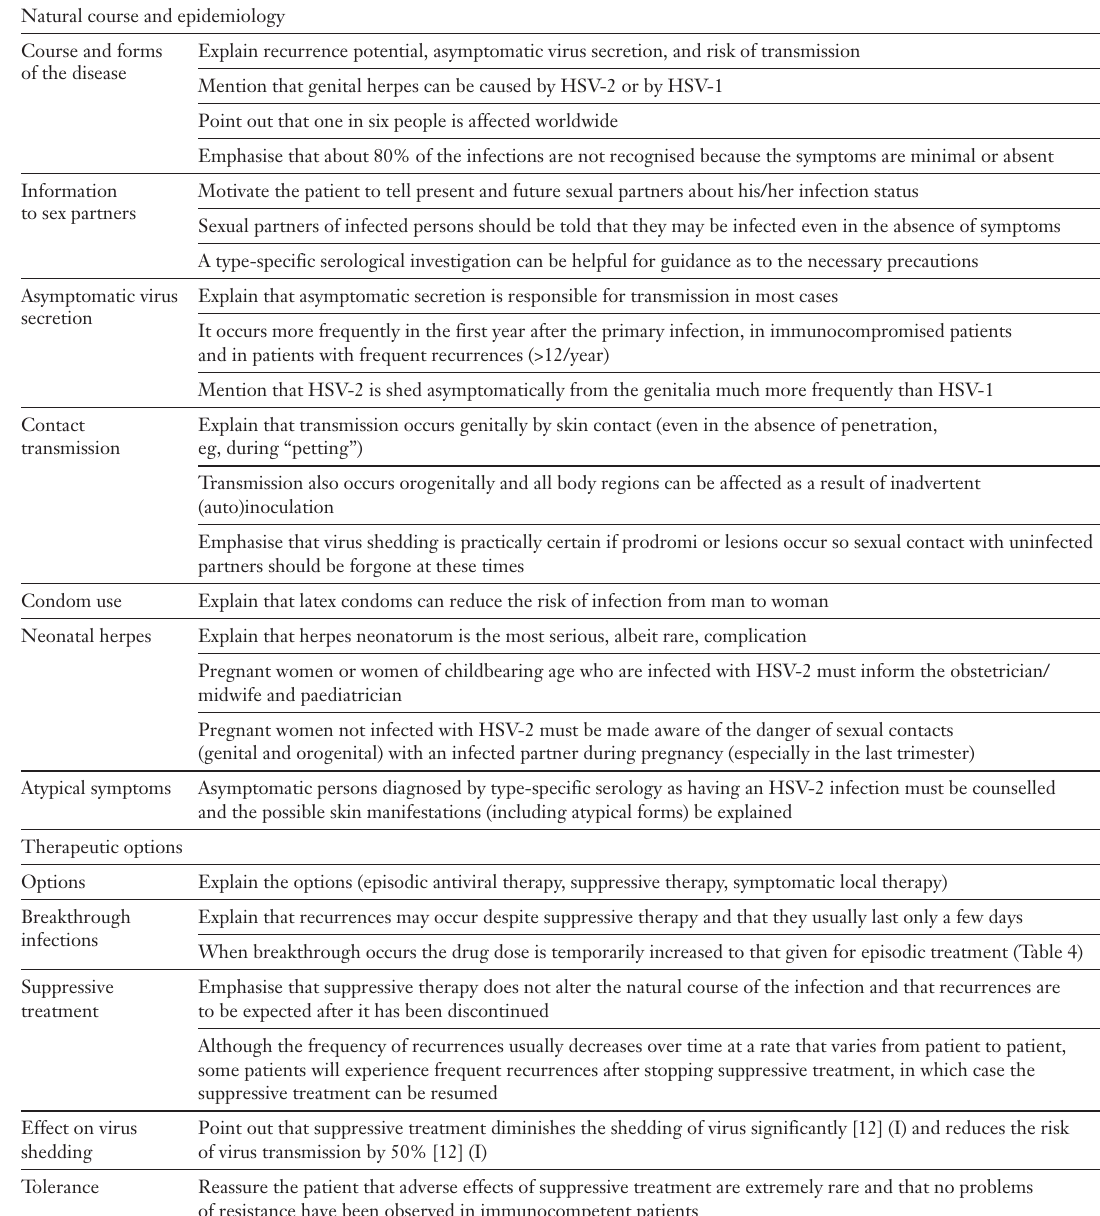
Patient counselling